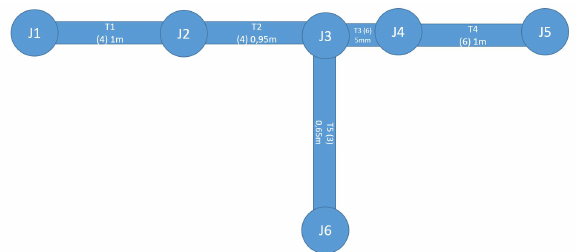
FIGURE 3: Topological model of the Figure 2 wiring net- work under study. The network model is made of junctions (J1 to J6) and tubes (T1 to T5). "(x)" denotes the number of conductors in the tubes.